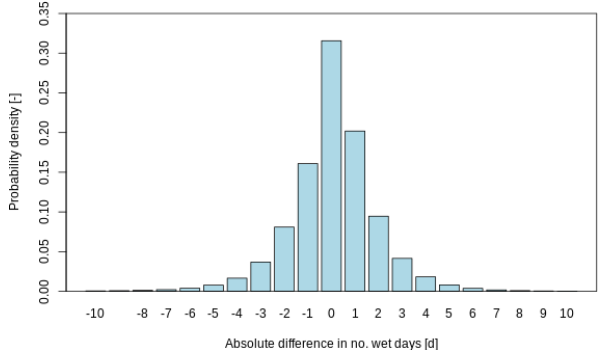
Figure 1. Distribution of the absolute difference in the number of wet days N wet estimated through the Stillman and Zeng (2016) method and gpcch P . The probability density function ranges glob- ally over all land grid